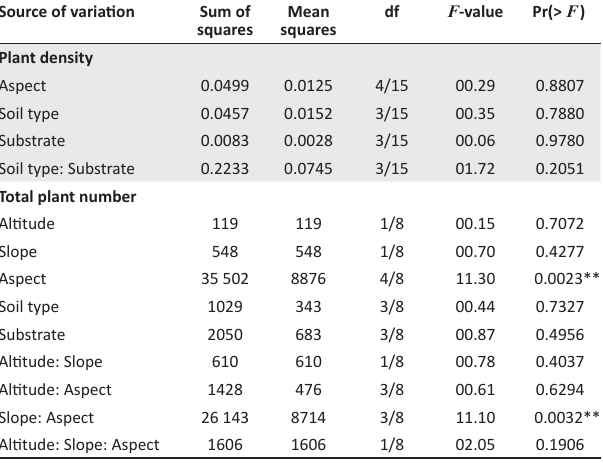
TABLE 4: Factors and co-variables selected by a general linear mixed model to explain variation in plant density and total plant number for 29 sites at Rössing Uranium Limited.